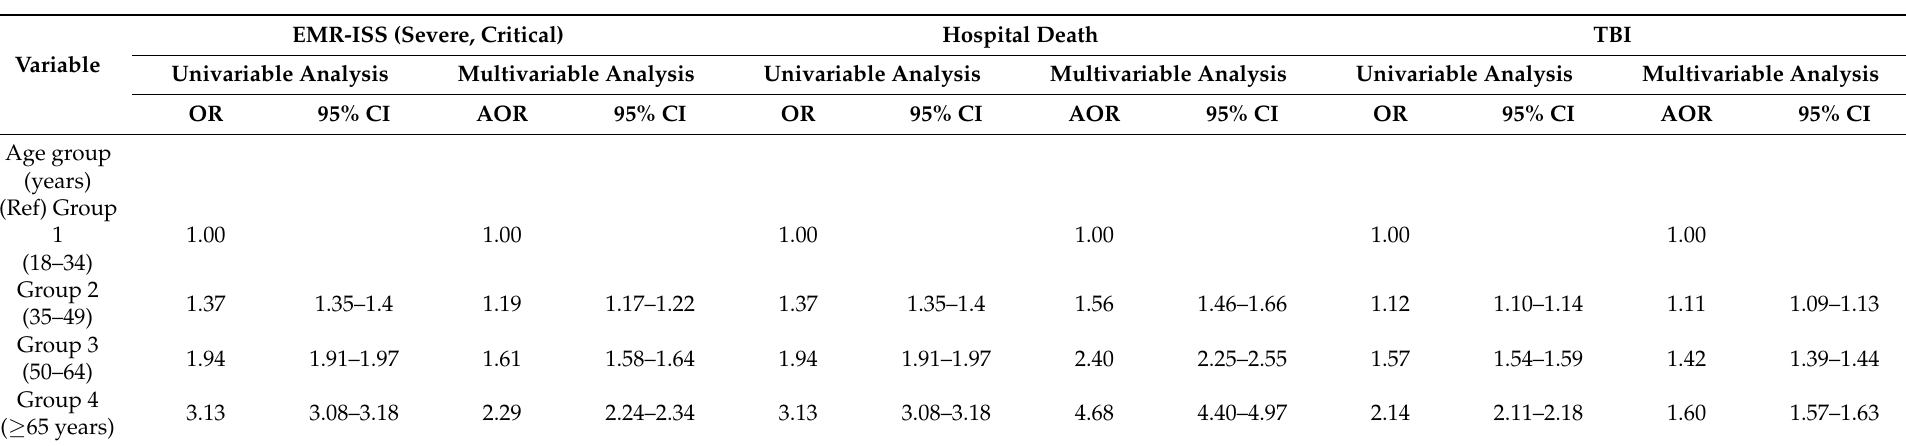
Table 5. Logistic regression analysis on clinical outcomes of injury patients (ERM-ISS, Hospital Death, and